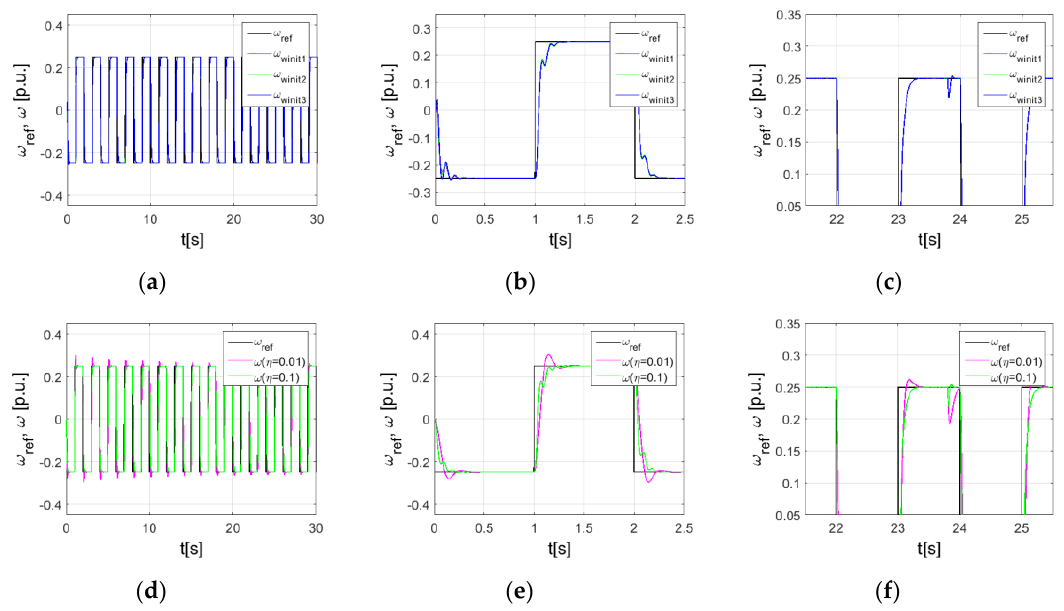
Figure 8. Transients of motor speed—influence of initial weight randomization ( a – c ) and influence of learning coefficient ( d – f